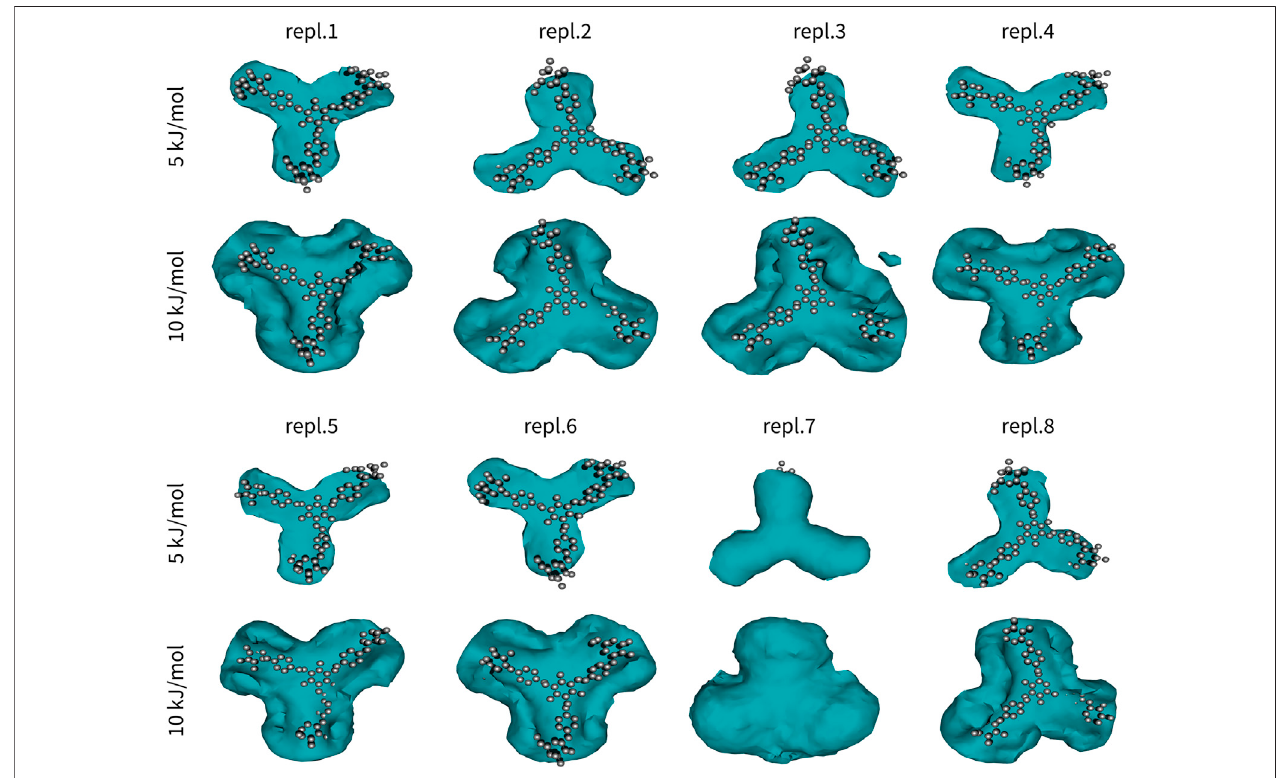
FIGURE2| InteractionsinYarivreagentdimer(Y2).OnemoleculeofYarivwas fi ttedtotheinitialcoordinates.Coordinatesofthesecondmoleculewereanalysedin terms of a free-energy-like function. This function is depicted as isosurfaces at 5 or 10 kJ/mol (relative to the global minimum).